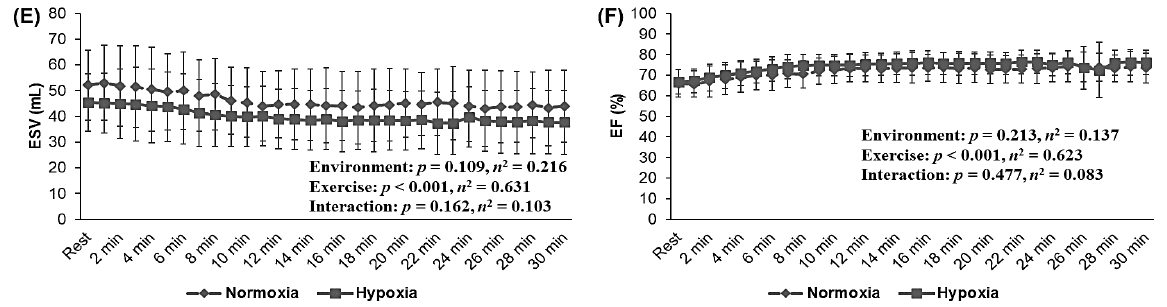
Figure 6. Changes in cardiac function during 30 min of the endurance exercise at the same relative exercise intensity (70%HRmax) under normoxia (760 mmHg) and hypoxia (526 mmHg, simulated 3000 m). ( A ) HR, ( B ) SV, ( C ) CO, ( D ) EDV, ( E ) ESV, ( F ) EF. HRmax: maximal heart rate; HR: heart rate; SV: stroke volume; CO: cardiac output; EDV: end-diastolic volume; ESV: end-systolic volume, EF: ejection fraction. The bars indicate the mean ± S.D. Skeletal muscle oxygenation, measured using NIRS, reflects the dynamic balance be- tween local oxygen supply by microcirculation and oxygen consumption by the mito- chondria [27]. Endurance exercise under hypoxia decreases skeletal muscle oxygenation,